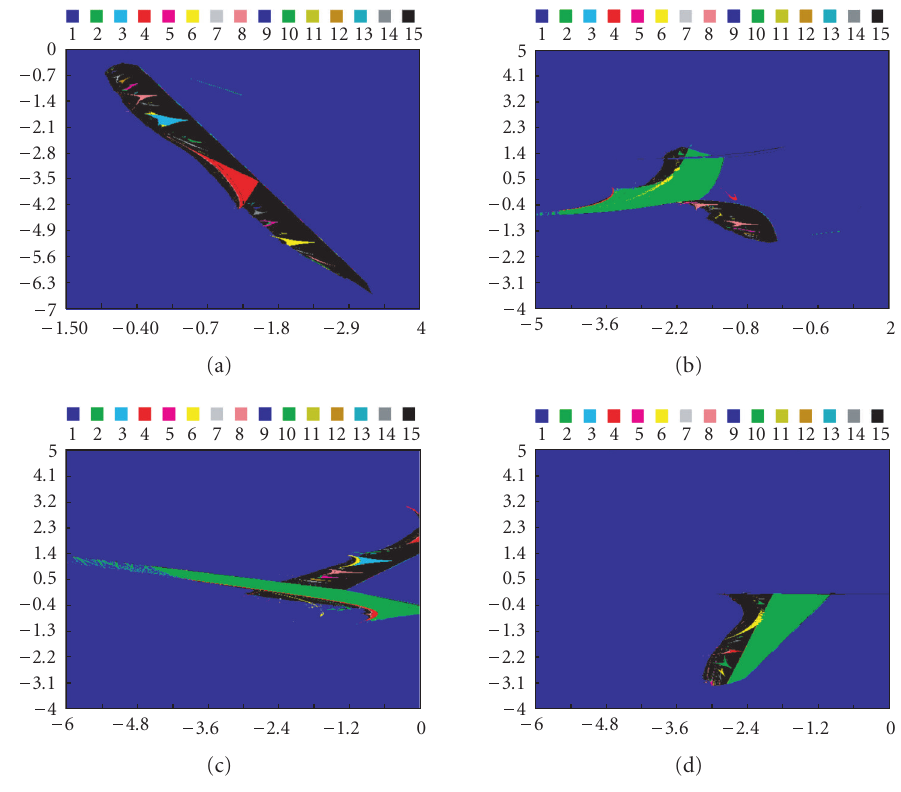
Figure 1.2. Bifurcation diagrams, (a) in ( a +1, c ) plane for h = 0 . 9, d = − 1, (b) in ( a +1, d ) plane for h = 0 . 9, c = − 0 . 7, (c) in ( a +1, h ) plane for c = d = − 0 . 7, (d) c = d =